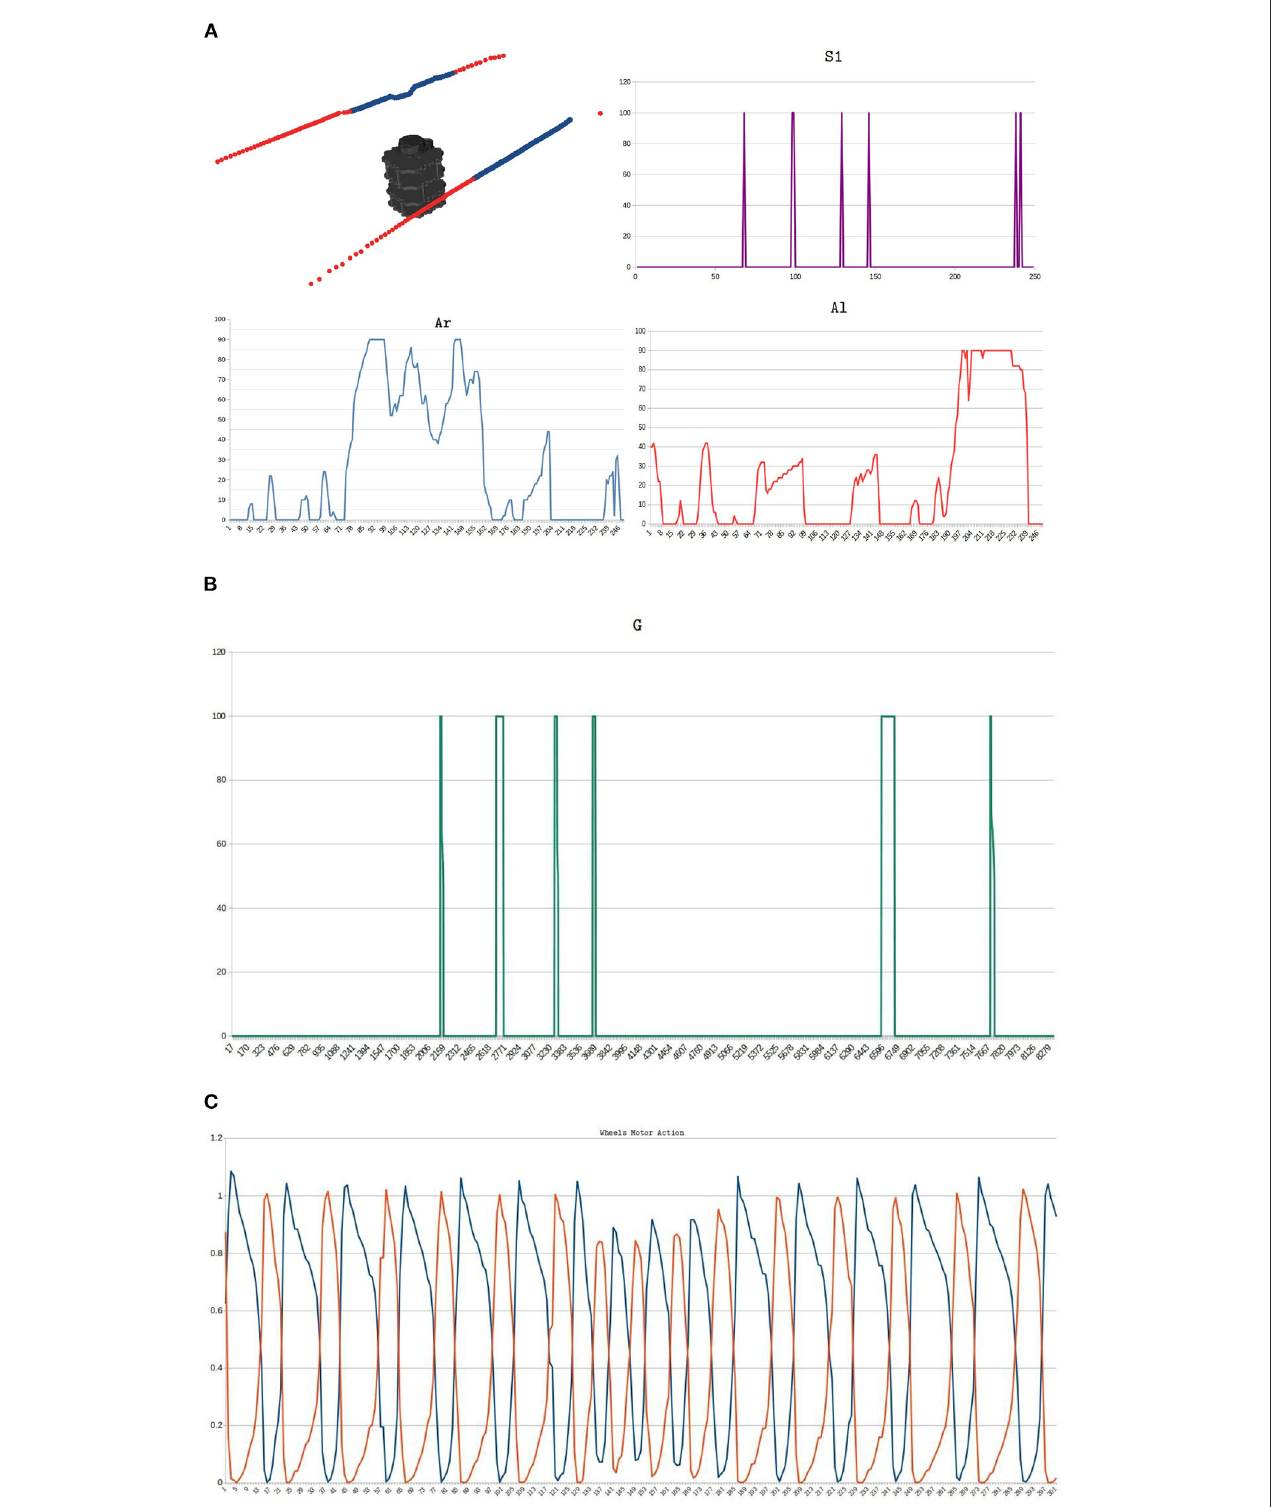
FIGURE13 Implementation of the zigzag environment. (A) Real signals obtained from the environment and its processing in time. The top left image exhibits the LiDAR’s points processing inside a corridor of the zigzag environment. Blue dots correspond to the points inside the safe area and red dots are the points outside the safe area. S 1 , A r , and A l curves are the inputs signals for the bio-inspired network (Section 2.5), these were sampled within an interval of 360 ms . The automaton’s trajectory seen in Figure 12E is a result of processing A r and A l signals. The biggest values of A r and A l appear when the robot executes turns. (B) Meta-control circuit projection G . (C) Motor control signals of the mobile automaton. This signal was sampled within an interval of 1.0 ms . Blue and orange signals correspond to the left wheel and the right wheel,